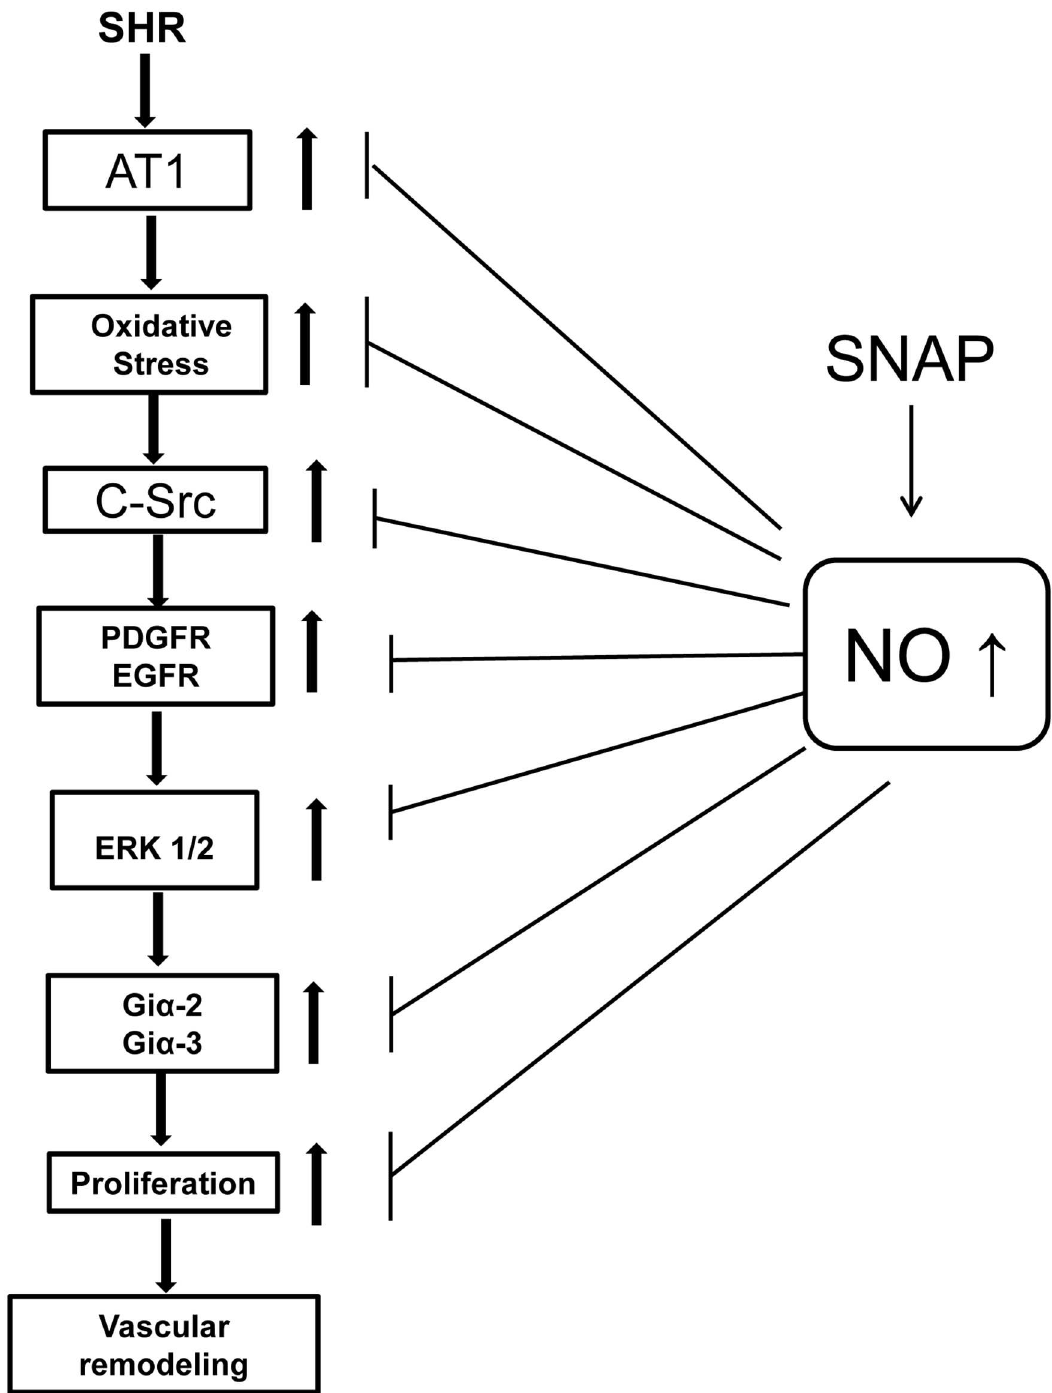
Fig 13. Schematic diagram summarizing the possible mechanisms by which SNAP attenuates the enhanced expression of Gi α proteins and hyperproliferation of VSMC.